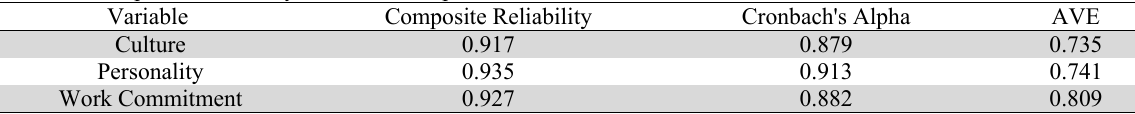
Values of Composite Reliability, Cronbach's Alpha,and AVE Variable Composite Reliability